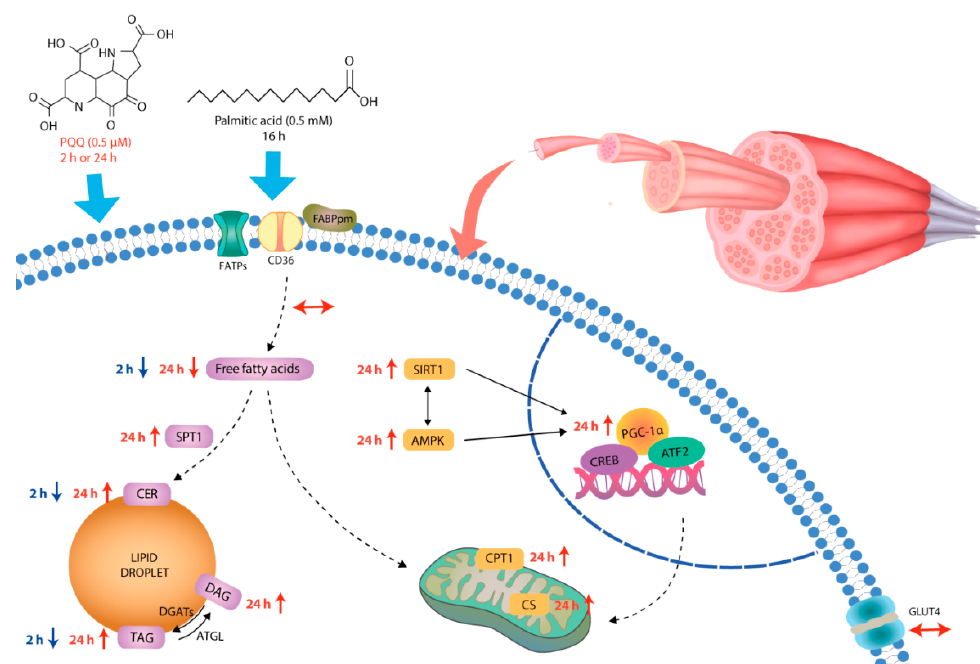
Figure 9. Effects of short- and long-time incubation with PQQ on energy substrate metabolism in L6 myotubes challenged with palmitate. ATF2: activating transcription factor 2; ATGL: adipose triglyceride lipase; AMPK: 5'AMP-activated protein kinase; CD36: cluster of differentiation 36; CER: ceramides; CPT1: carnitine palmitoyltransferase 1; CREB: cAMP-response element binding protein; CS: citrate synthase; DAG: diacylglycerols; DGATs: diacylglycerol O-acyltransferases;